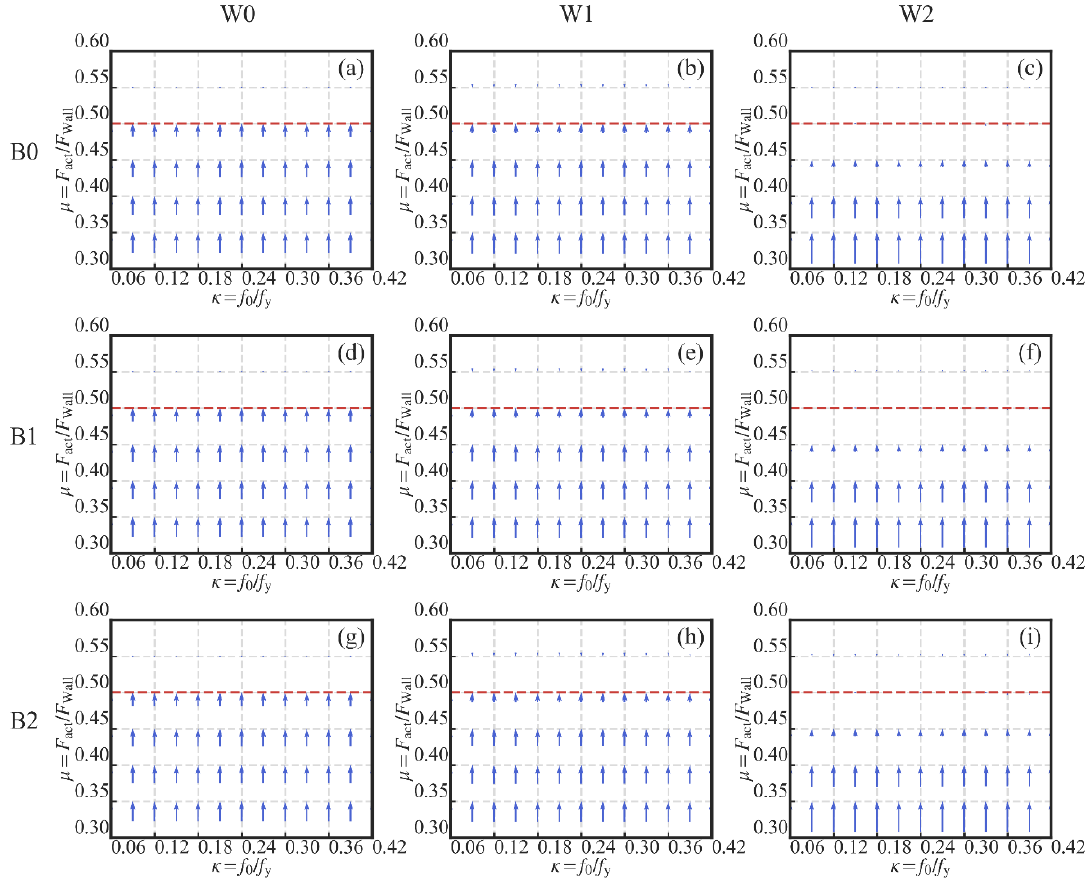
Figure 18. Gradient field (along the direction of the increase in µ ): ( a ) W0B0; ( b ) W1B0; ( c ) W2B0; ( d ) W0B1; ( e ) W1B1; ( f ) W2B1; ( g ) W0B2; ( h ) W1B2; ( i ) W2B2.